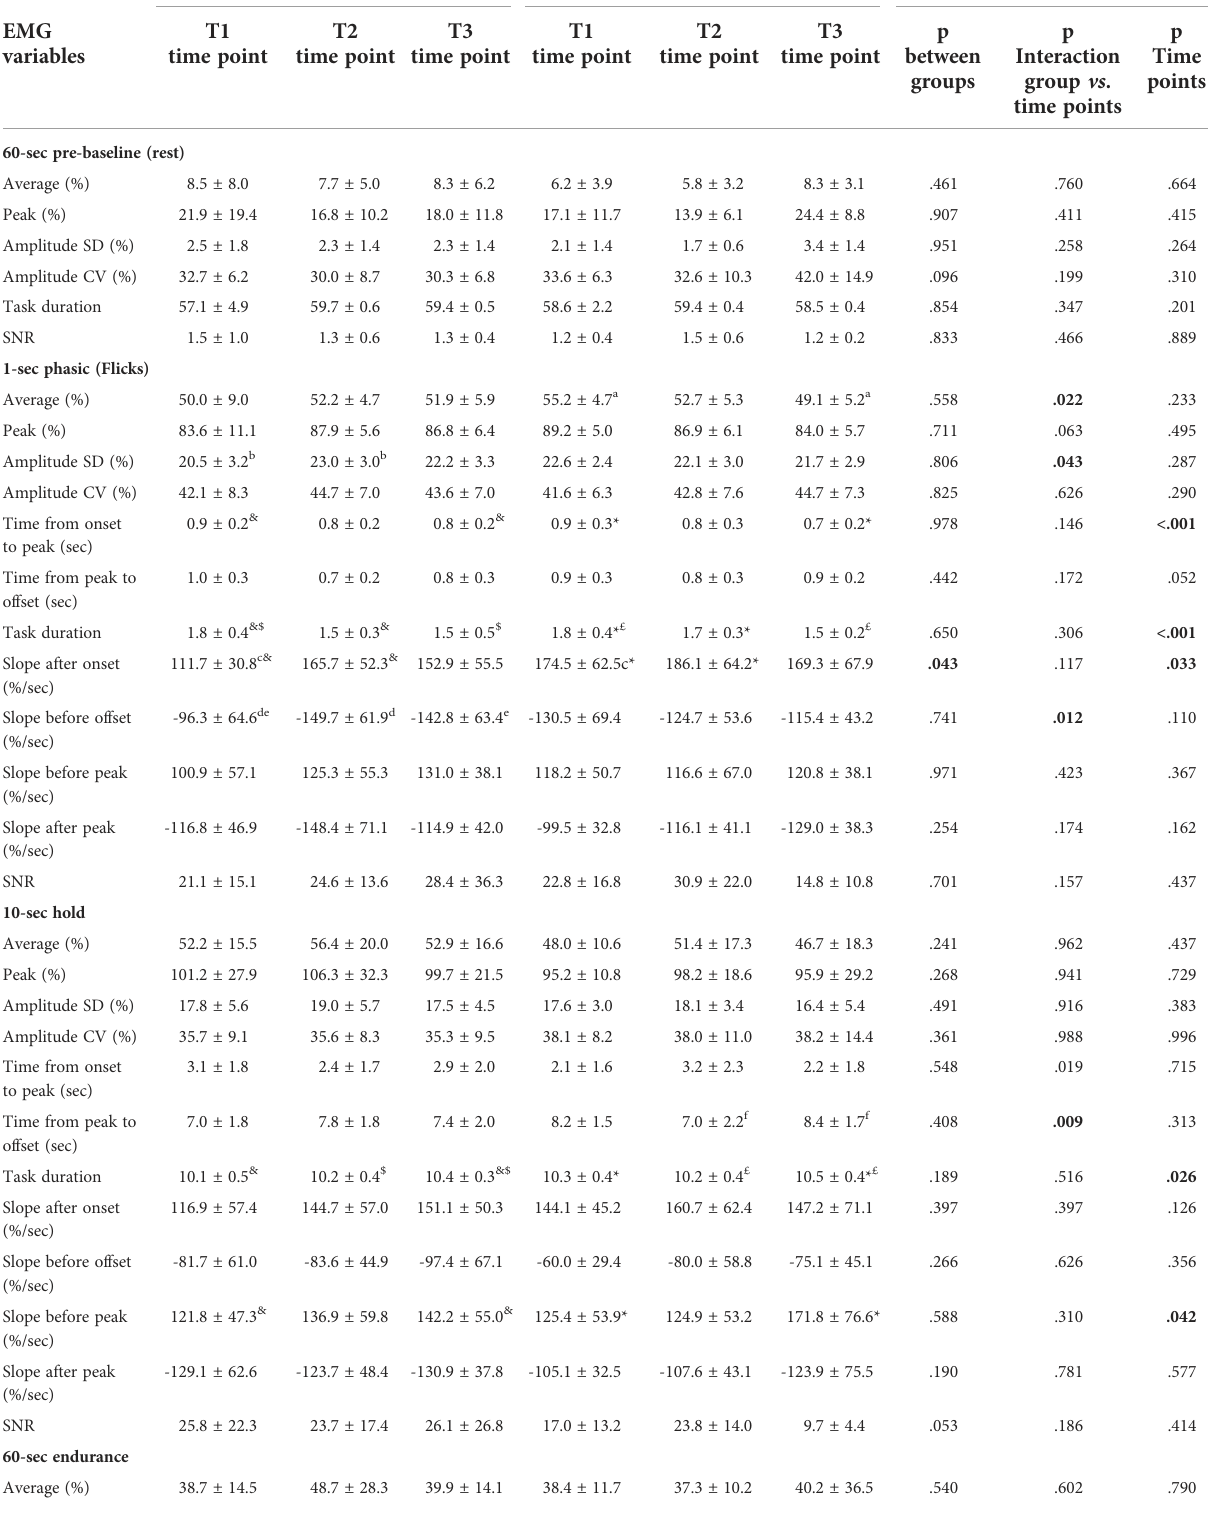
TABLE 2 Group mean ± standard deviation (across subjects) of the parameters extracted from the EMG signals at each task of the Glazer protocol. Non-GDM (19) GDM (14) General linear